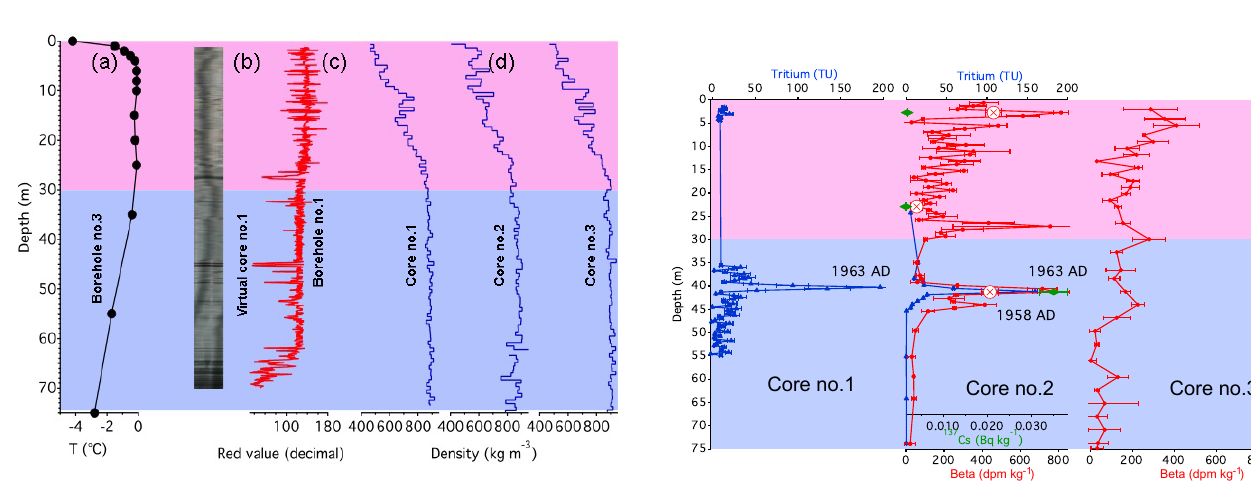
Figure 8. Fission products determined in the Mt. Ortles cores no. 1, no. 2 and no. 3. The temperate firn portion is enclosed in red shad- ing, while the cold ice is in blue. Tritium is depicted by blue trian- gles, beta emissions by red dots (BPCRC) or red crosses (LGGE) and 137 Cs by green diamonds. Beta emissions in cores no. 2 and no. 3 are determined at different resolutions depending on the sam- ple mass